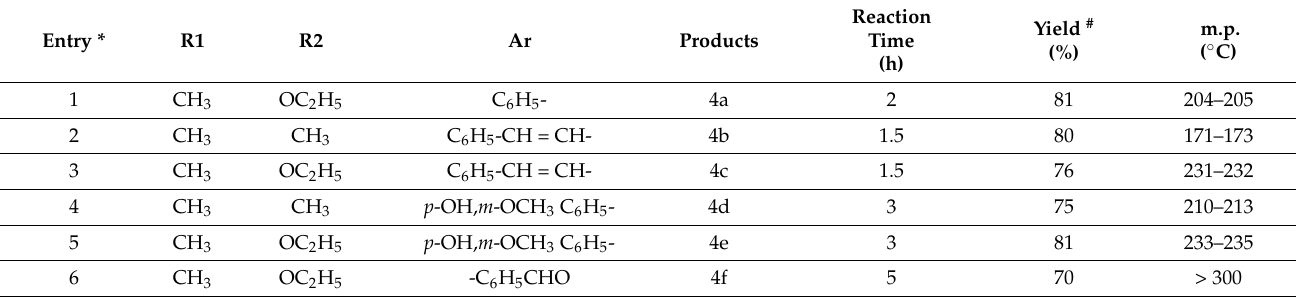
Table 1. Synthesis of 3,4-dihydropyrimidin-2( 1H )-ones.